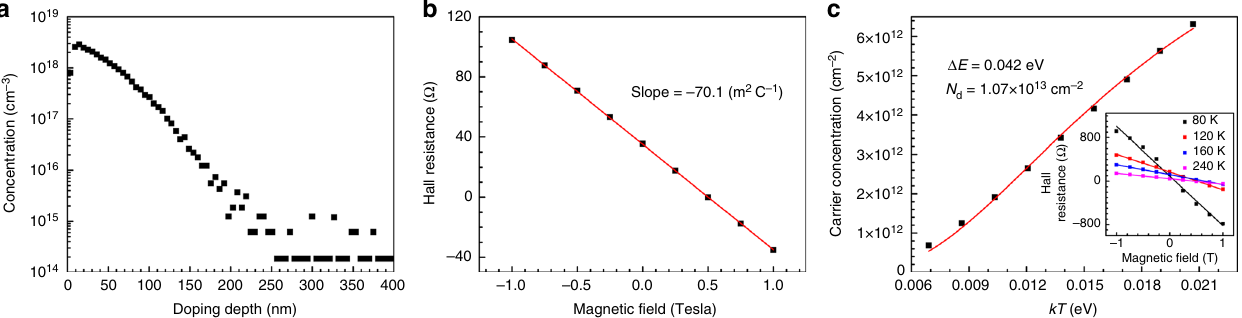
Fig. 3 Dopant ionization rate. a Doping pro fi le of phosphorus-doped Si measured by SIMS. b Hall resistance versus magnetic fi eld measured by Hall measurement at room temperature. c Free electron concentration versus temperature. Inset: Hall measurements of phosphorus-doped Si at several